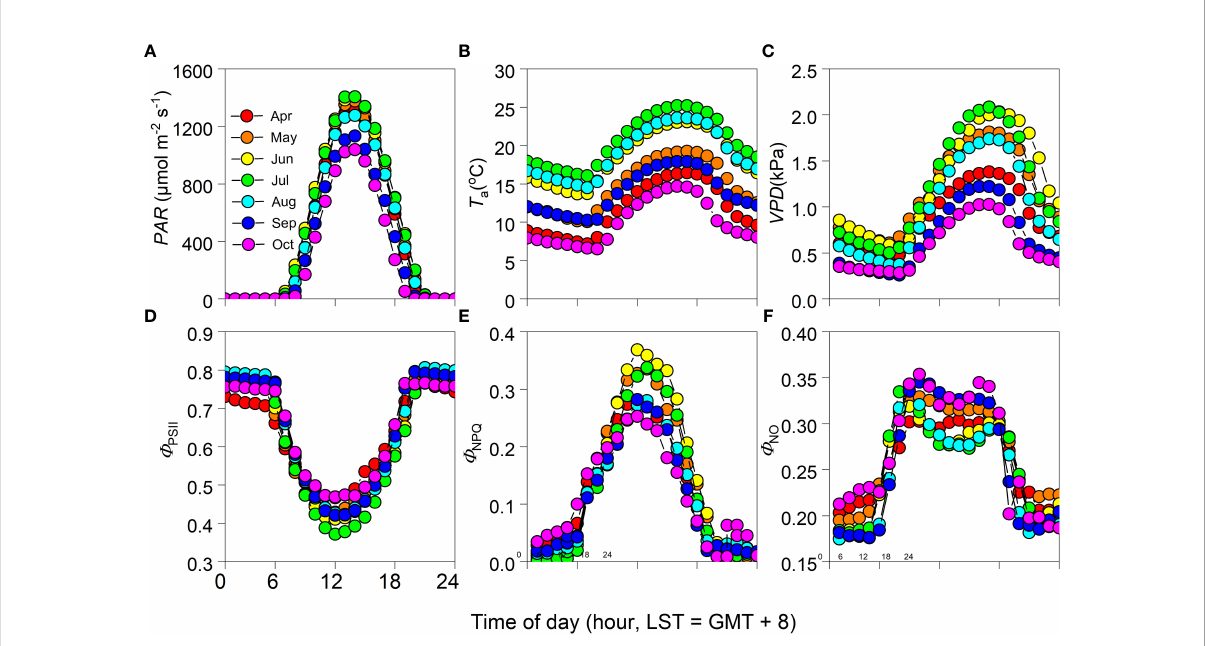
FIGURE 3 Monthly mean diurnal cycle of (A) photosynthetically active radiation ( PAR ), (B) air temperature ( T a ), (C) vapor pressure de fi cit ( VPD ), (D) photochemical ef fi ciency ( F PSII ), and (E) regulatory and (F) non-regulatory thermal dissipation ( F NPQ and F NO , respectively) during the growing seasons of 2012 – 2017 (i.e., April – October period of each